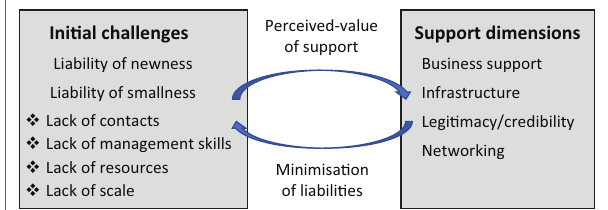
FIGURE 2: Potential of value-adding suppport by the business